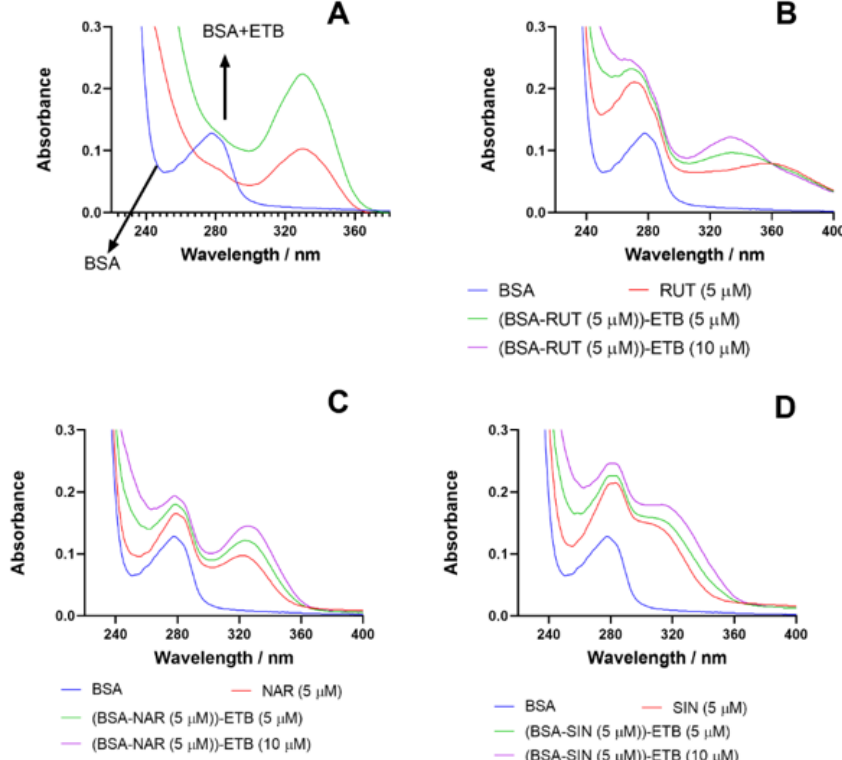
Figure 5. Ultraviolet-visible spectra for ( A ): BSA (1.5 µ M) in presence and absence of ETB (0.00–10 µ M) and in presence of ( B ): RUT; ( C ): NAR; ( D ): SIN.